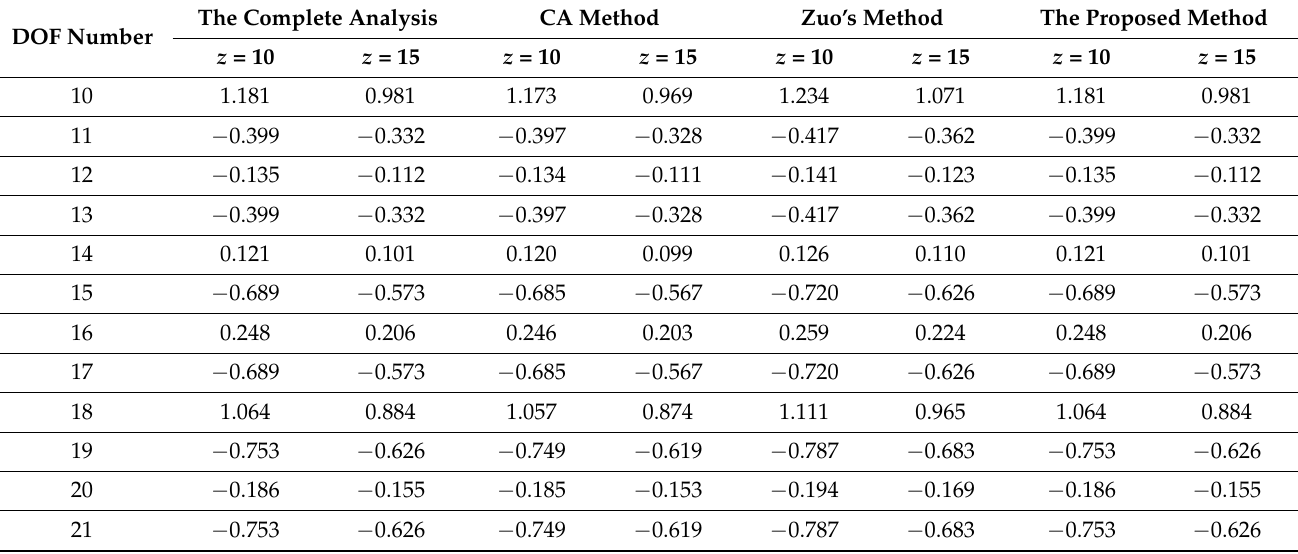
Table 11. Displacement sensitivities for modification type 3 when z = 10 and z = 15 ( × 10 − 5